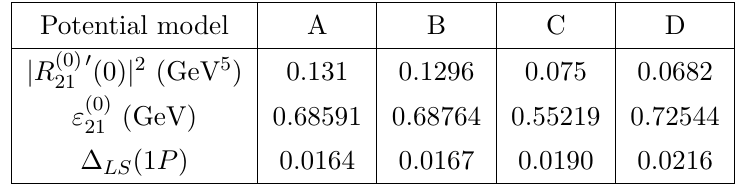
Table 1 . For the four potential models described in the text, we list the squared derivative of the radial wavefunction at the origin, j R (0) 0 correction de(cid:12)ned in eq. (4.2), (cid:1) LS (1 P ), of the charmonium 1 P